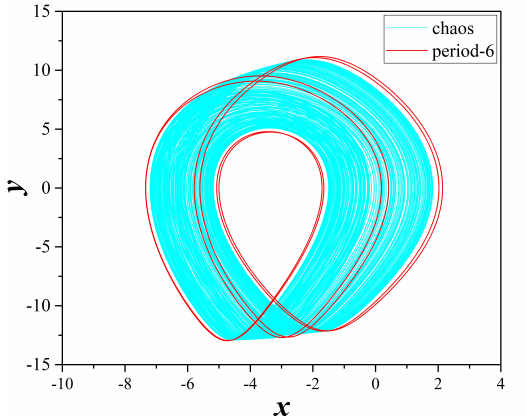
Figure 9. Coexisting attractors of system (2), for a = 4 × 10 − 4 , b = 1, c = 3.846 × 10 − 4 , e = 1 and d = 10.1. With cyan color and for ( x 0 , y 0 , z 0 ) = ( 0,0.1,0 ) a chaotic attractor, while with red color and ( x ) = ( − 5.7896825,0,2.9007334 ) a period-6 attractor. 0 , y 0 , z 0